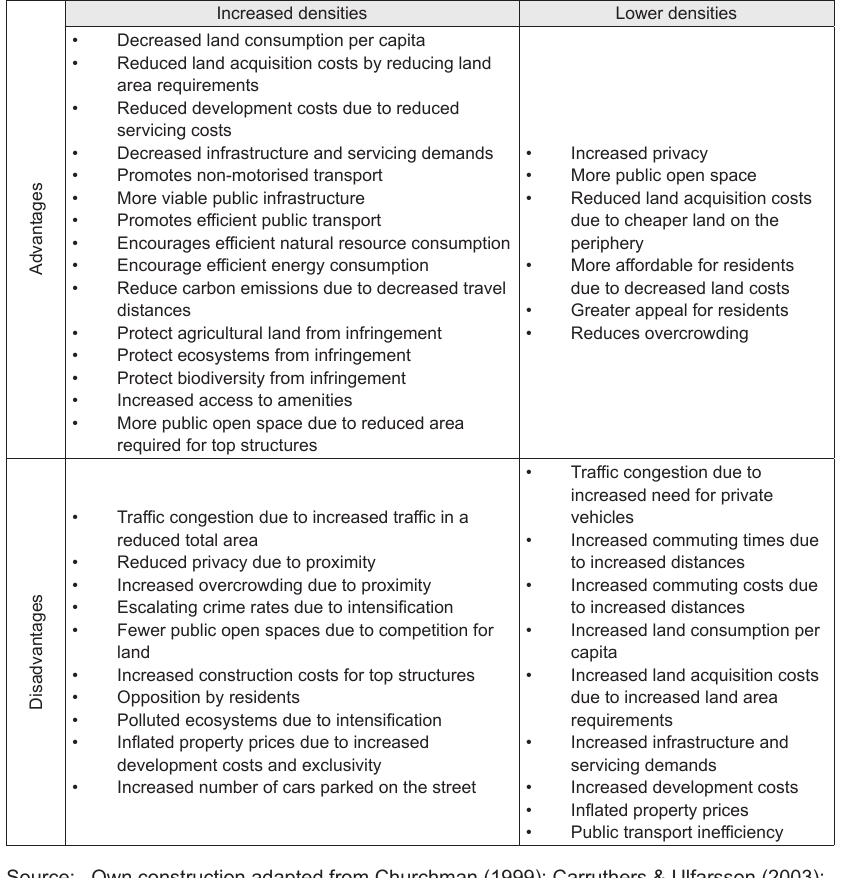
age s an t v A d